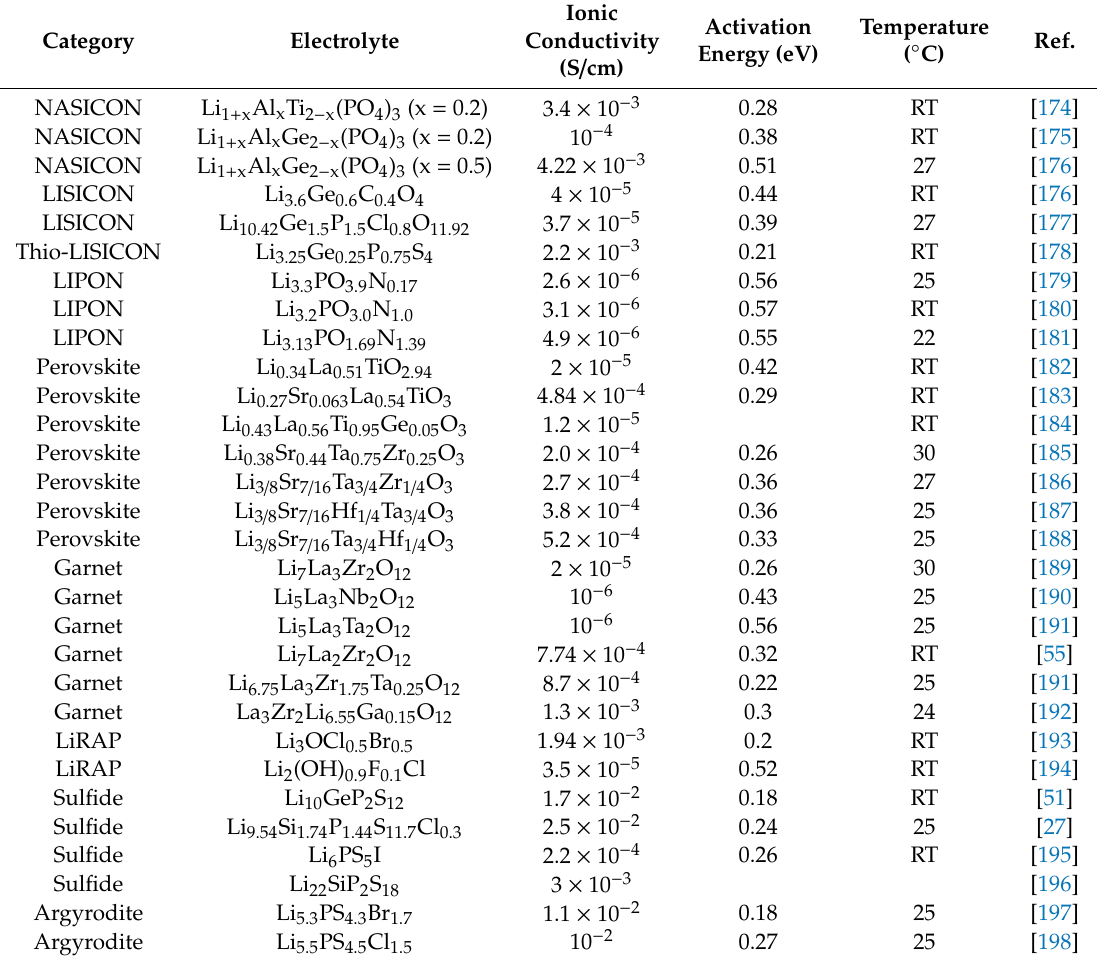
Table 3. Comparison of the ionic conductivities of di ff erent solid